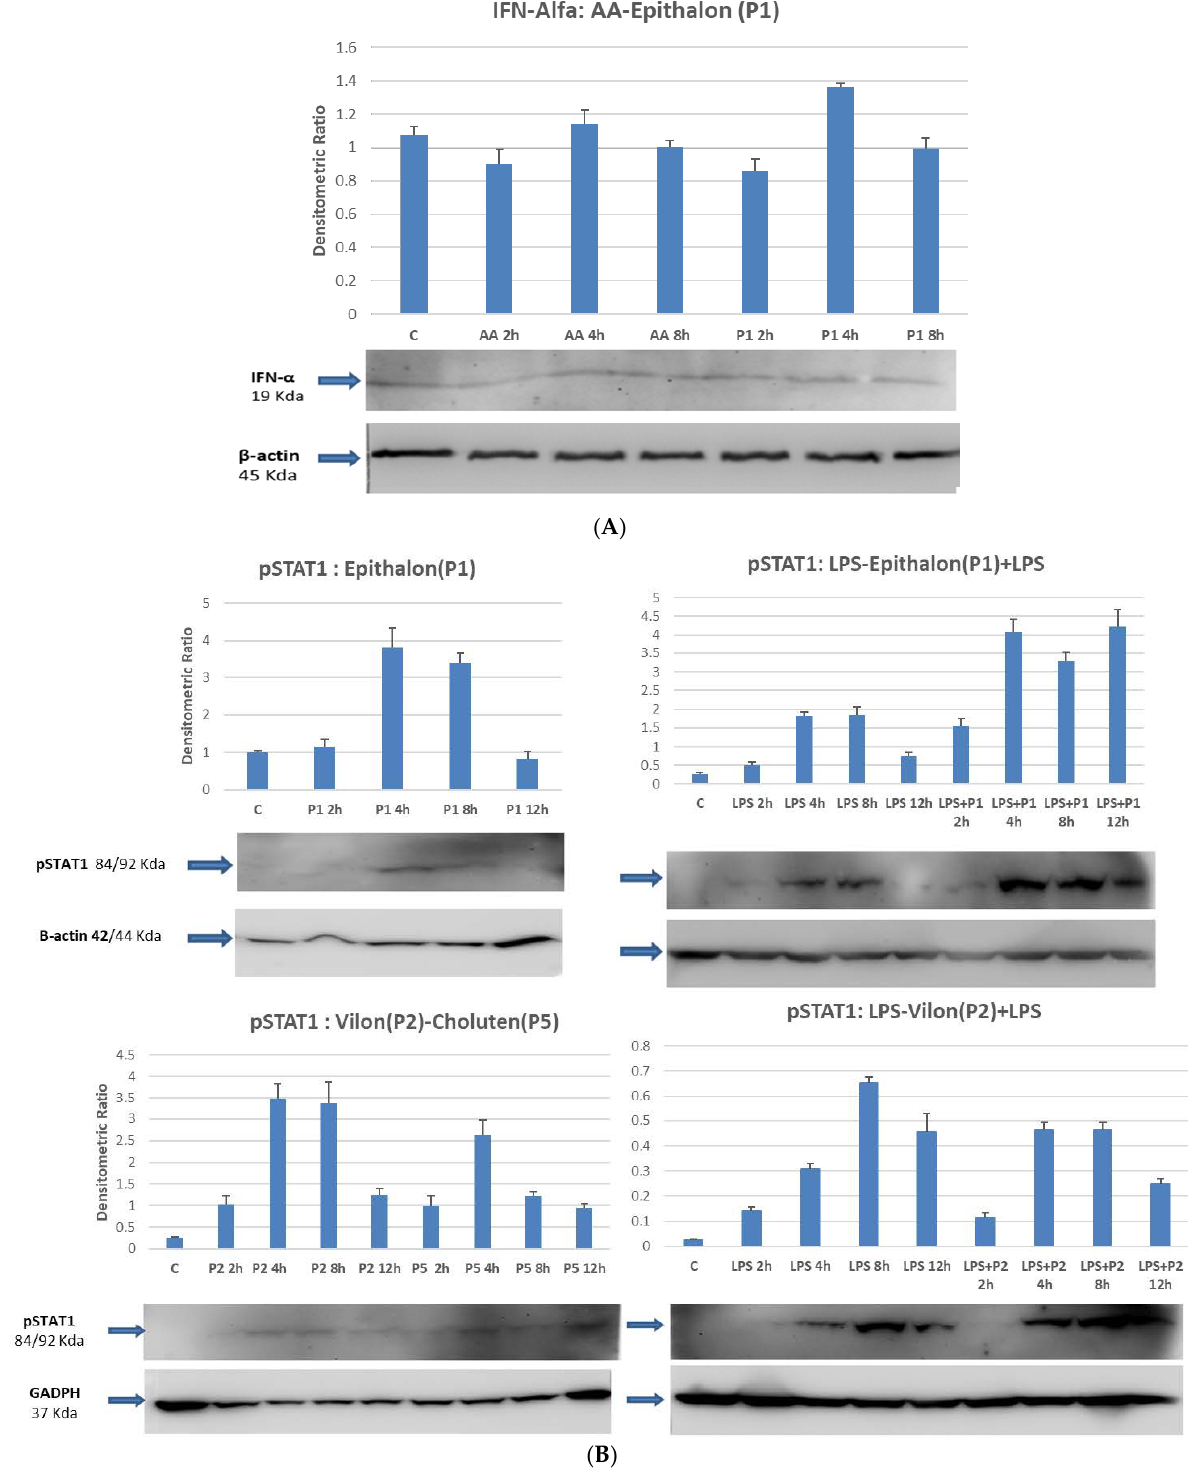
Figure 3. ( A ) IFN-a Detection of IFN-a by Western Blot assay. THP-1 cells were treated with either P1 peptide or a mix of amino acids (AA). No significant modulation was observed among the different pools of extracts. ( B ) Synergistic activation of STAT-1 by LPS. Epitalon (P1), Vilon (P2) and Chonluten (P5) biopeptide treatments of macrophage differentiated THP-1 cells. Phospho-activation of STAT-1 by bio-peptides on a time course treatment of differentiated macrophage THP-1 cells Bar graphs show the mean values of three independent experiments.